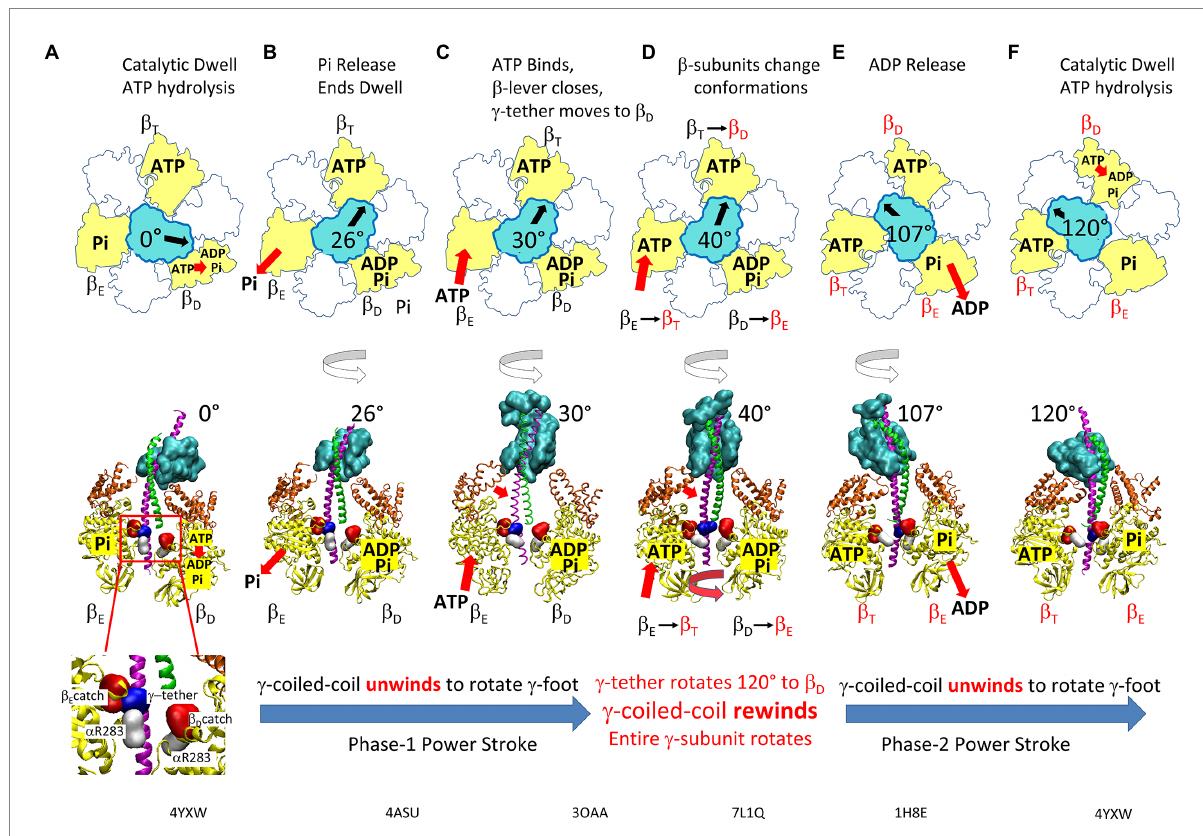
FIGURE 10 Elastic Coupling Mechanism of the F 1 -ATPase Power Stroke. (A) Catalytic dwell where ATP hydrolysis occurs at β D . Inset: residues of the β E - and β D - catch loops (red), the γ -tether (blue), and aR283 (white). (B) Pi release from β D initiates Phase-1 power stroke using torsion energy from tightly wound γ -coiled-coil to rotate γ -foot. (C) As γ -coiled-coil unwinds, ATP binds β E from 20 ° –50 ° (optimally 34 ° ) to force β -lever closed and rotate γ -foot further. (D) γ -tether moves from β E -catch loop to β D -catch to rotate γ -coiled-coil 120 ° and rewind it to initiate Phase-2 power stroke. This initiates catalytic site conformational changes β E → β T , β T → β D , and β D → β E . (E) Release of ADP upon β D → β E occurs from 78 ° –110 ° (optimally 93 ° ). (F) Catalytic dwell state after γ -foot rotates 120 ° . Structures corresponding to the indicated γ -foot rotation positions are Bt F 1 4YXW at 0 ° (A) and 120 ° (F) , Bt F 1 4ASU at 26 ° (B) , EcF 1 3OAA at 30 ° (C) , GsF 1 7L1Q at 40 ° (D) , and Bt F 1 1H8E at 110 ° (E) . Top view structures as viewed from γ -foot, while side view structures omitted α -subunits and the rear β -subunit for clarity. White, α -subunits; yellow, β -subunits; orange, β -levers; cyan, γ -subunit foot; green and pink, γ -coiled-coil. This figure was modified from that in Martin et al.